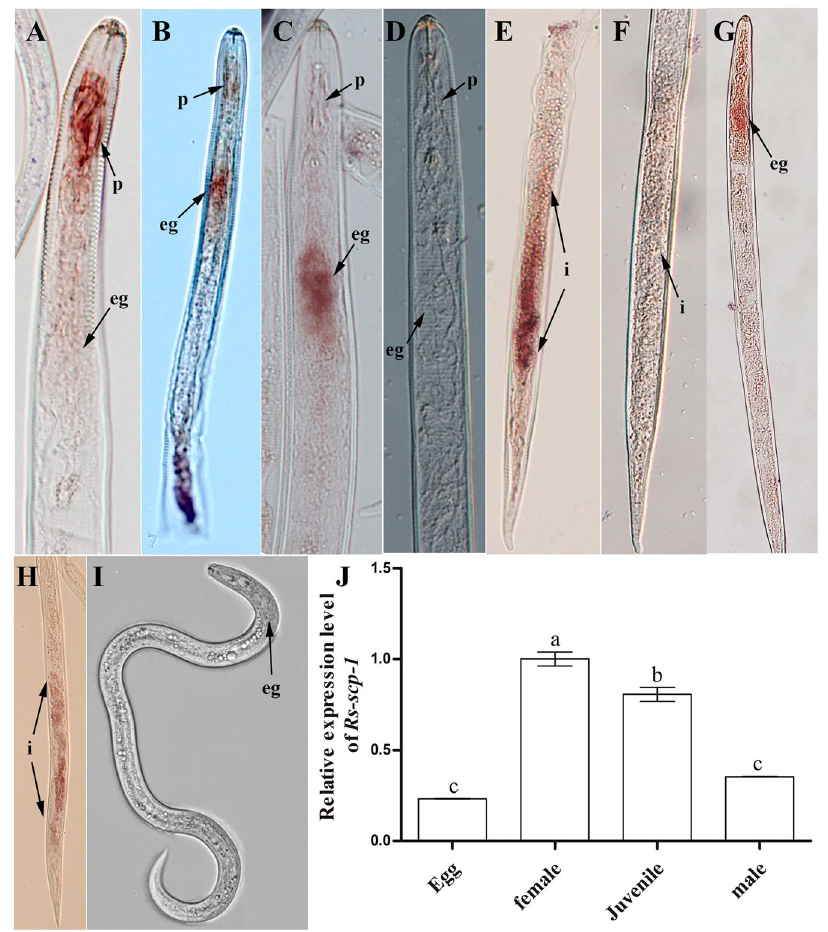
Figure 5. Tissue localization and expression levels of Rs - scp - 1 in Radopholus similis . ( A – I ) Tissue localization of Rs - scp - 1 mRNA via in situ hybridization. Rs - scp - 1 was located in the procorpus ( A ), oesophageal glands ( B , C ), and intestines ( E ) of females and the oesophageal glands ( G ) and intestines ( H ) of juveniles. There were no hybridization signals in control females ( D , F ) and juveniles ( I ) hybridized with a DIG-labelled sense Rs - scp - 1 RNA probe. p, procorpus; eg, esophageal glands; i, intestine. ( J ) Rs - scp - 1 expression levels at different life stages of R . similis . Bars indicate standard error of the mean (n = 3), and different letters indicate significant differences (p < 0.05) between